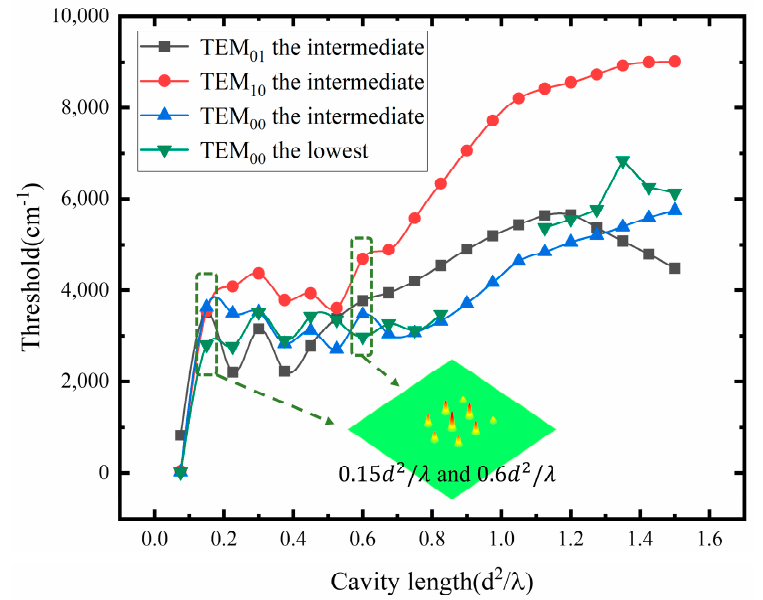
Figure 8. The changes of the minimum thresholds among supermodes of the high-order transverse mode (TEM 01 and TEM 01 ) array which may be generated with the duty ratio F = 0.2 and the lowest mode threshold of the TEM 00 transverse mode array versus the external cavity length of 0.075 − 1.5 d 2 / λ